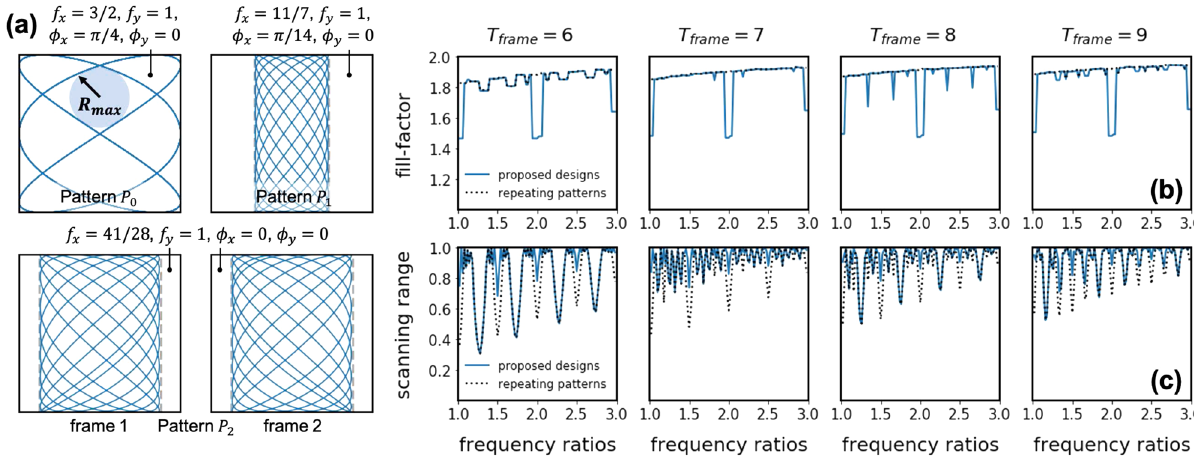
Figure 1. ( a ) Several scanning patterns for a resonant scanner with f r x = 1.5 , f r y = 1.0 and T frame = 7 . Pattern P 0 is the on-resonance actuated pattern, Although it has large scannning range 1.0, fill-factor is low (0.63), as indicated by the radius of its largest inscribed circle. Pattern P 1 uses f x = 11 / 7 , f y = 1 , φ x = π/ 14 , φ y = 0 as parameters. The fill-factor is improved to 0.89 but scanning range is reduced to 0.45. Pattern P 2 uses f x = 41 / 28 , f y = 1 , φ x = 0 , φ y = 0 , derived from design rule 1. It has fill-factor = 0.88 and scanning range = 0.74 . ( b , c ) Fill-factor/Scanning range with proposed design rule 1 (blue, solid) and repeating-pattern design rule 18 (black, dashed), with different resonant frequency ratio and T frame